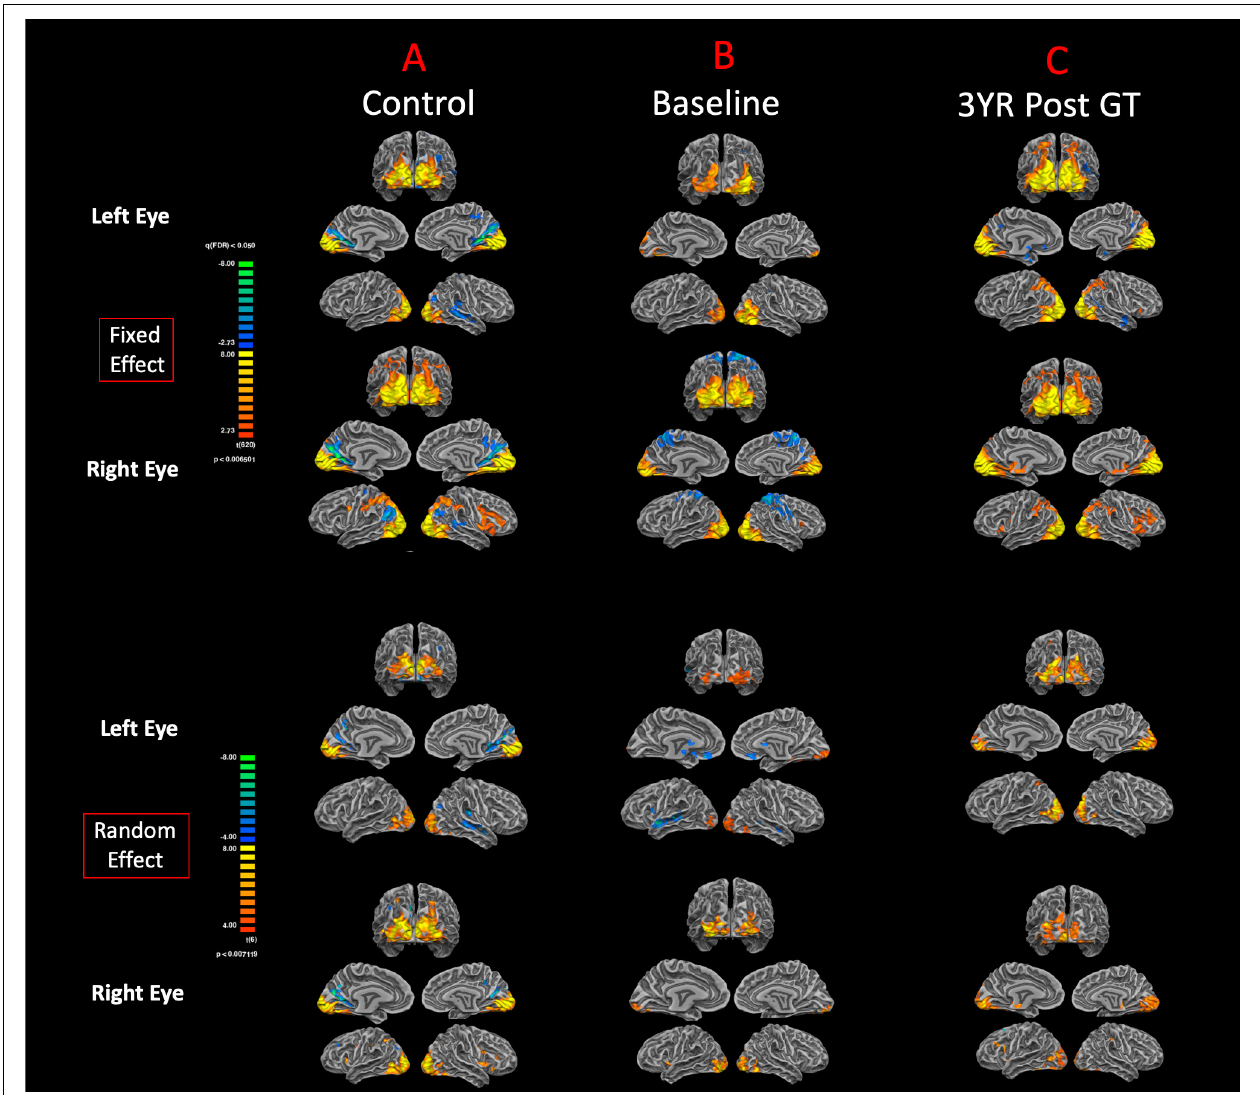
FIGURE 5 | Functional magnetic resonance imaging response to visual stimulation. The visual stimulation tasks were presented either to the left or right eye of (A) normal-sighted controls, (B) RPE65 patients before GT, and (C) RPE65 patients 3 years after GT. All task-based cortical activations were processed using FX analyses at FDR corrected p < 0.007 ( q < 0.05), with an extent threshold of > 100 mm 2 and RFX analyses at an uncorrected p < 0.007 with an extent threshold > 100 mm 2 . Sighted controls showed significant bilateral cortical activations in the visual cortex. At baseline, RPE65 patients expressed asymmetric and attenuated hemispheric activations in the left eye because the left eye was untreated in seven of eight patients. However, visual stimulation of the right eye in RPE65 patients displayed nearly symmetrical bilateral activation of the visual cortex. Three years post–FO clinical trial when RPE65 patients’ contralateral eye was treated, symmetrical bilateral visual cortex activations were observed for both left and right